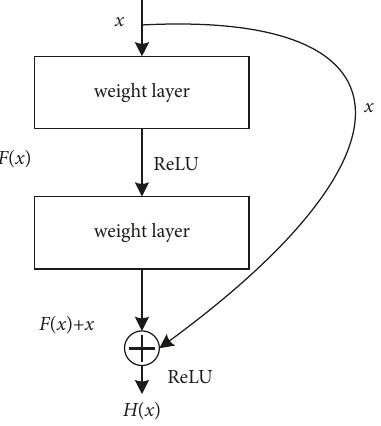
Figure 7: A residual